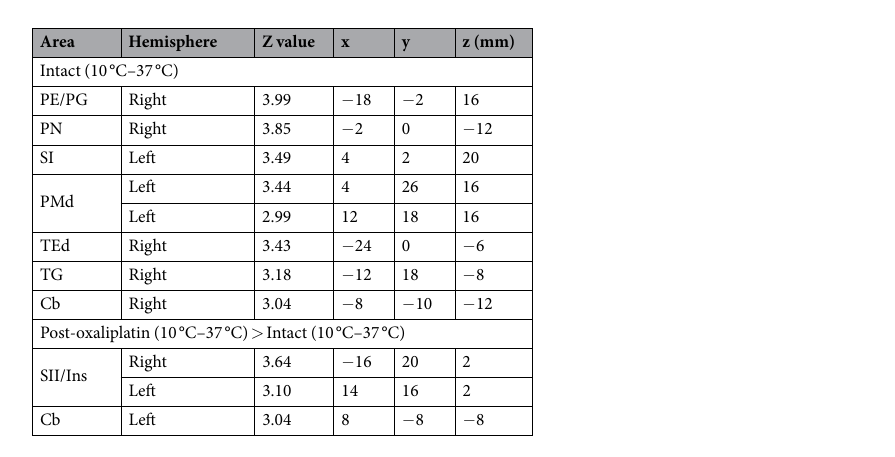
Table 1. Brain areas showing significantly increased activation before and after oxaliplatin infusion. Z -value of the peak voxels are indicated. The locations are indicated with the positions along the x (ipsi-contralateral), y (rostro-caudal) and z (dorso-ventral) axes of the Horsley-Clarke stereotaxic coordinates. Cb, cerebellum; PMd, dorsal premortor cortex; TEd, dorsal inferotemporal cortex; Ins, Insular cortex; PE/PG, PE/PG of the inferior parietal cortex; PN, pontine nuclei; SI, primary somatosensory cortex; SII, secondary somatosensory cortex; TG, temporal